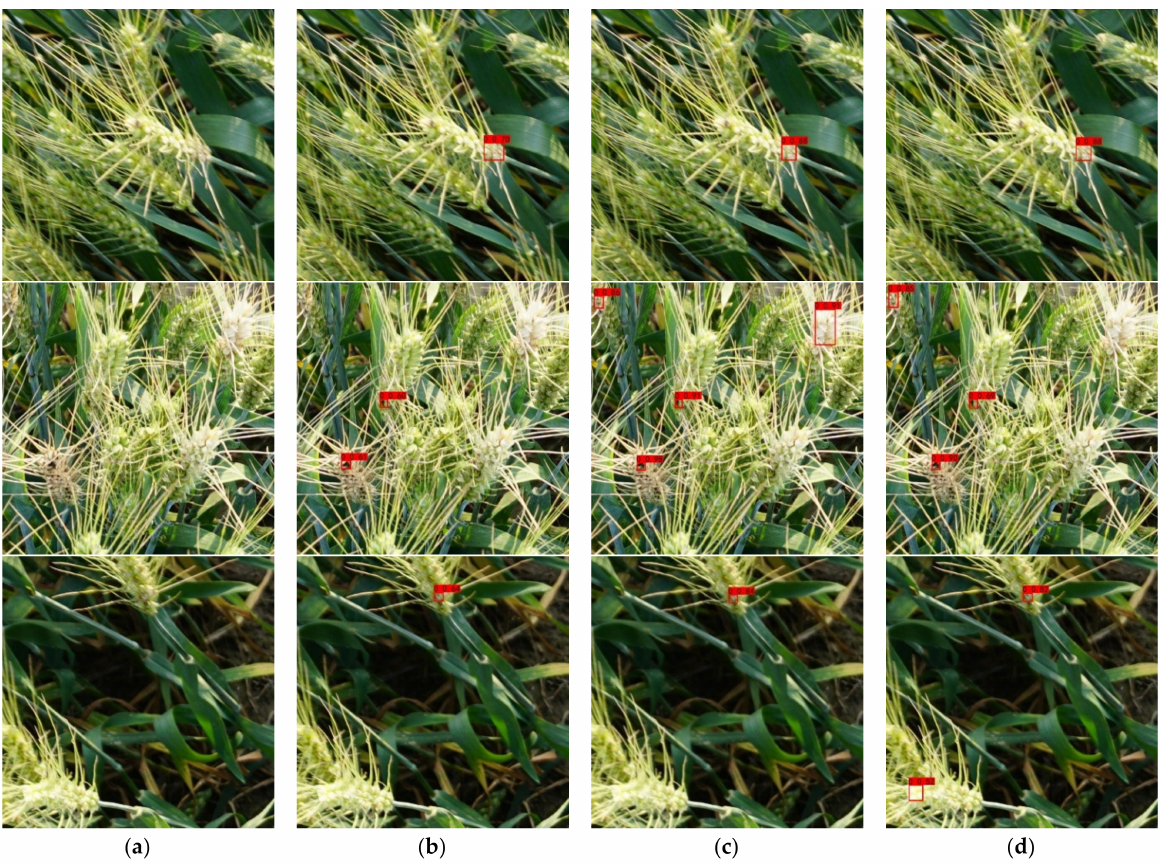
Figure 13. Comparison between manual annotation and the proposed model. ( a ) Manual annotation and ( b ) detection results of the proposed